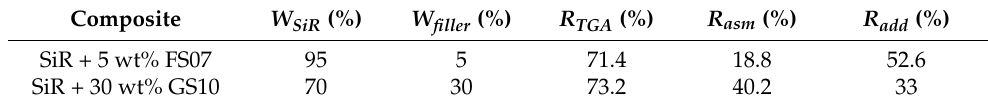
Table 3. Calculation of the additional residue R add of the composites.